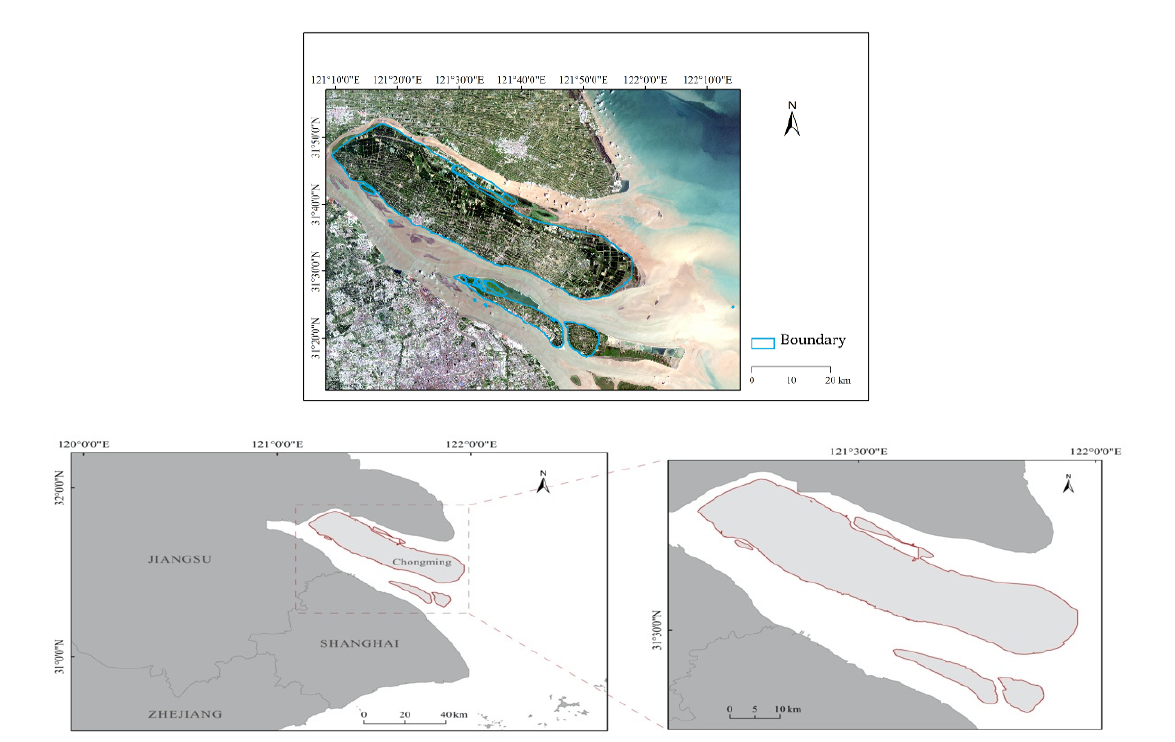
Figure 1. Location of the study area: Chongming District.